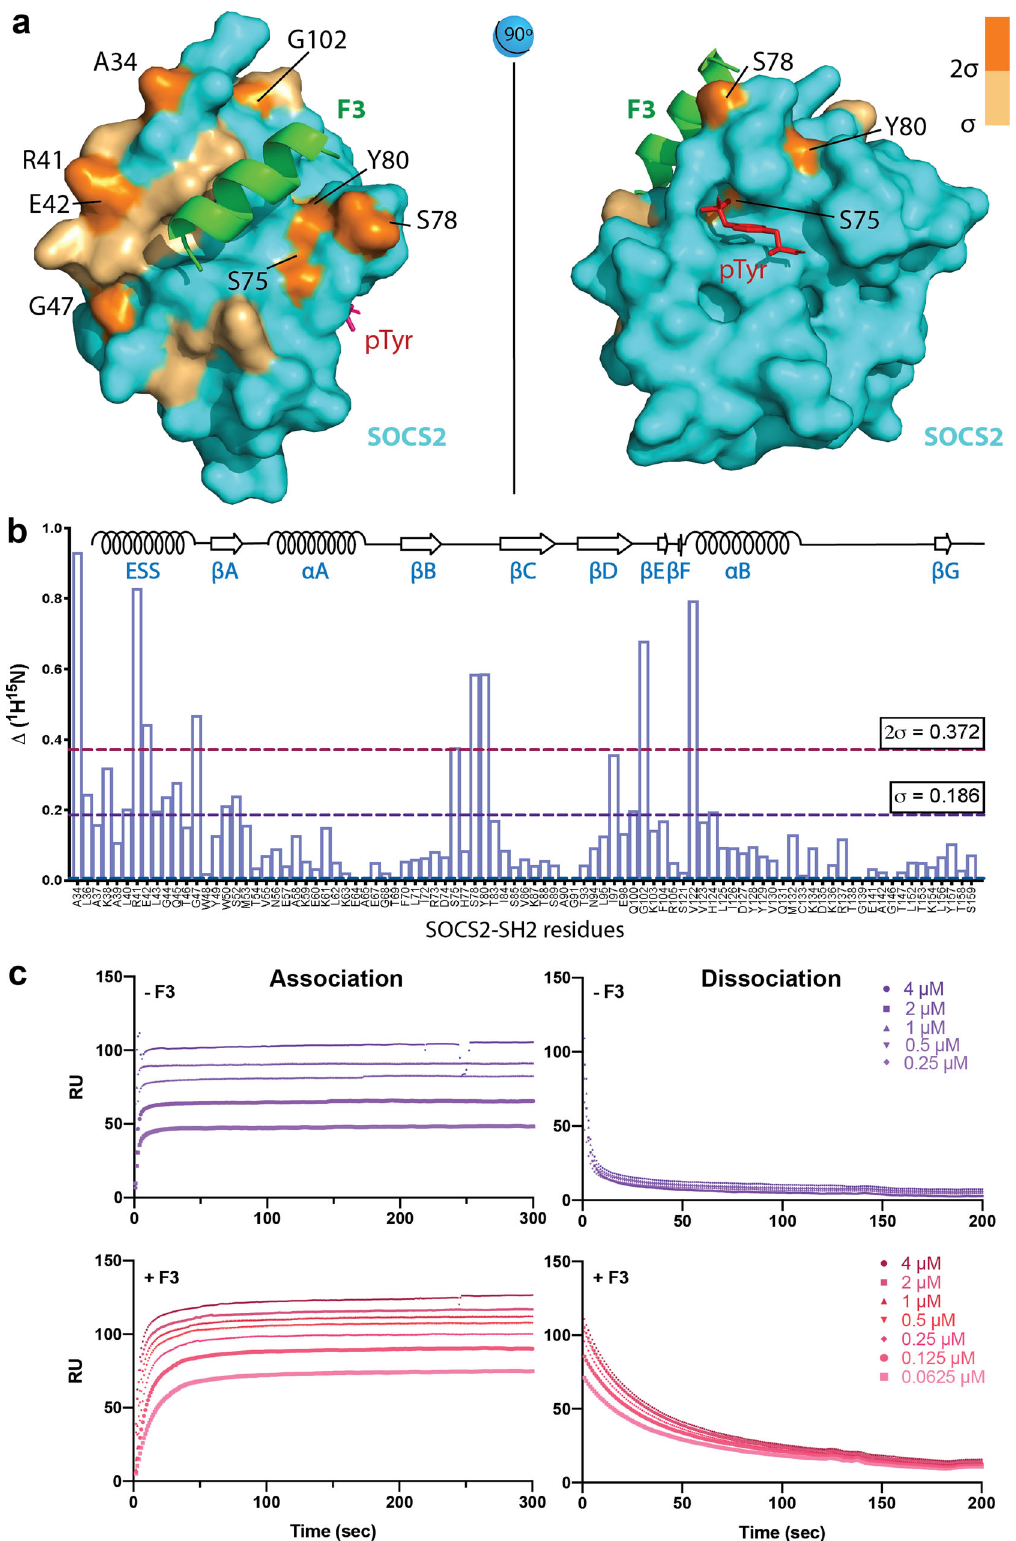
Two key polar residues were identi fi ed in F3, with alanine substitutions of His6 and Lys10 abrogating binding. His6 cannot be substituted for alanine, but can be substituted for lysine, which can presumably replicate the polar interactions with SOCS2- Tyr49 and Asp74. Although electron density for the full Lys10 side chain is not visible, the most favorable rotamer